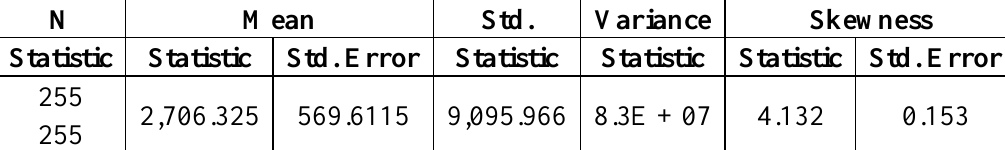
Table 1. Descriptive statistics.